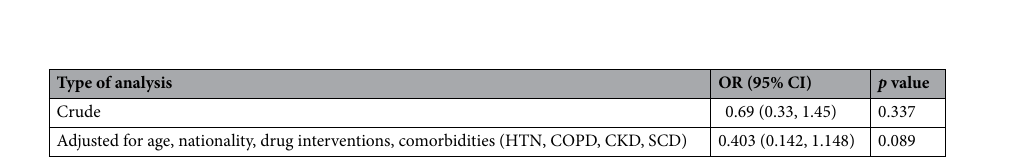
Table 5. Odds of suffering the primary outcome in patients with G6PDd compared to non-G6PDd patients. HTN Hypertension, COPD Chronic Obstructive Pulmonary Disease, CKD Chronic Kidney Disease, SCD Sickle Cell